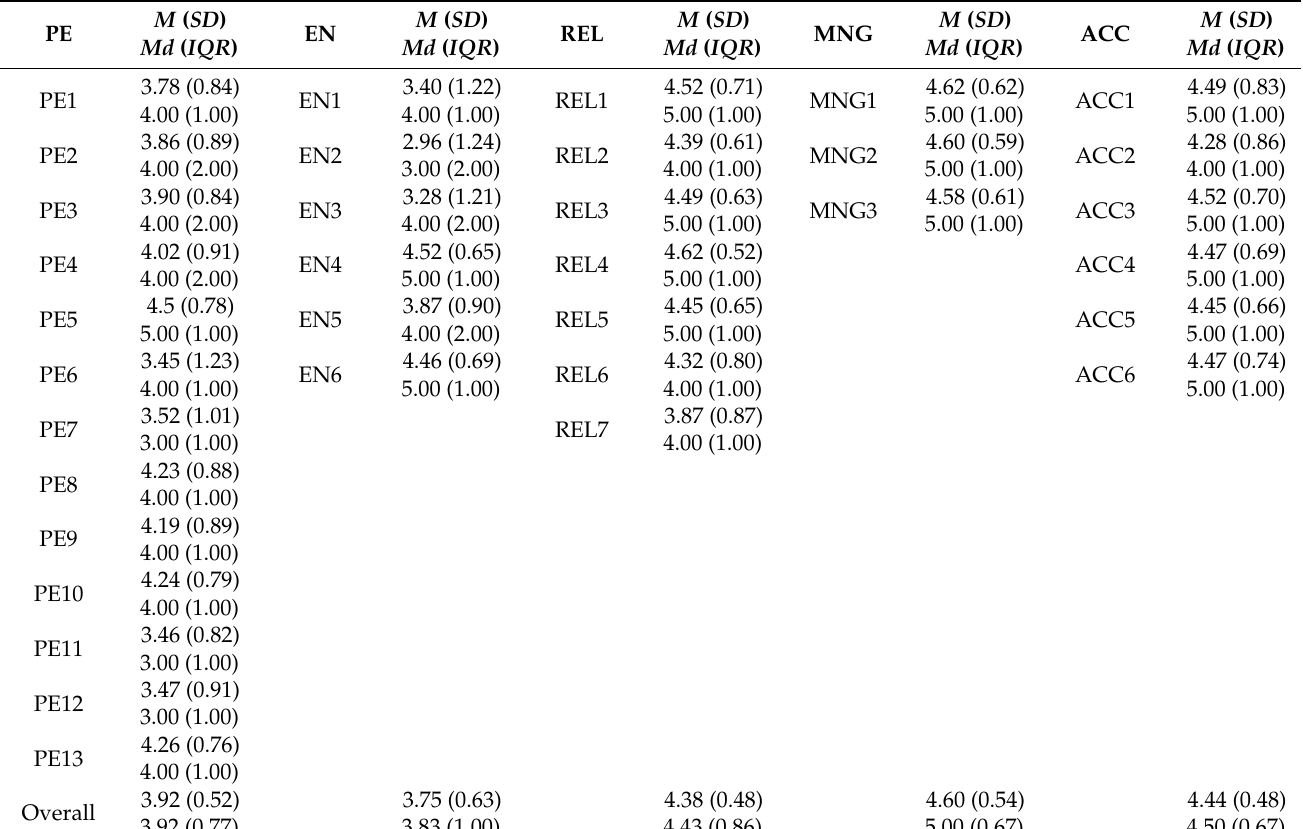
Table 1. Descriptive statistics for individual items of the sub-domains and for the overall